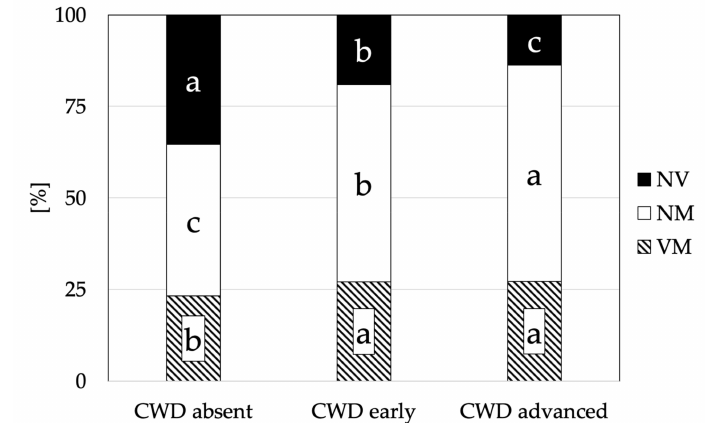
Figure 1. The abundance of vital mycorrhizal (VM), non-vital (NV), and vital non-mycorrhizal (NM) root tips (%) from oak trees in three study sites, based on the absence of coarse woody debris (CWD absent ) and early (CWD early ) and advanced (CWD advanced ) stages of wood decay. Within bars of each root tip classification, di ff erent letters indicate significant di ff erences (Tukey´s contrast, p =